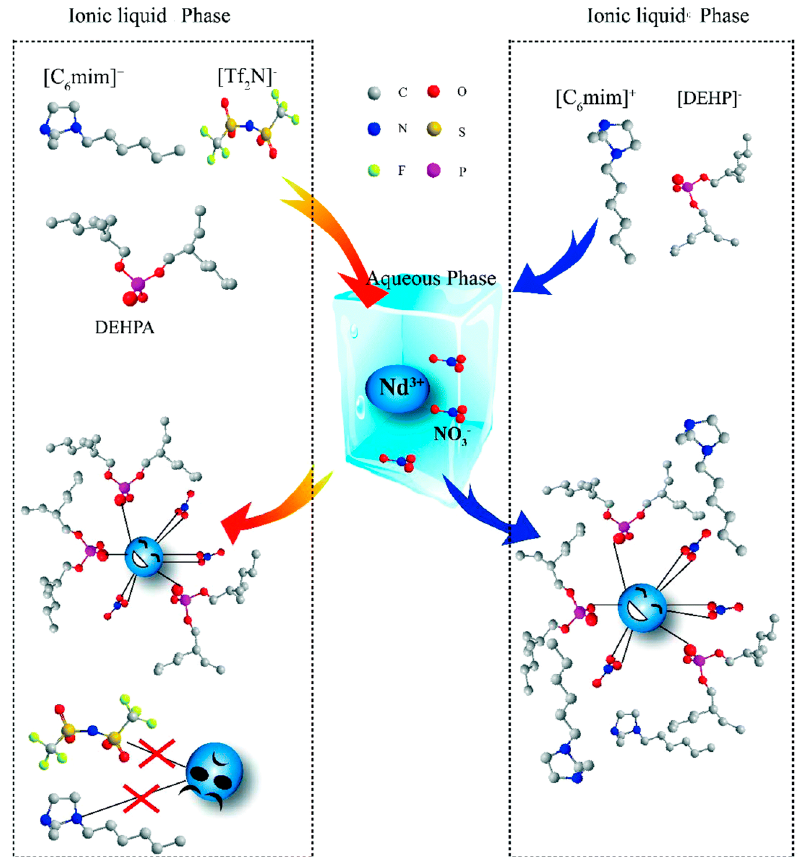
Figure 18. Different Nd 3+ extraction behaviors in [C 6 mpyr][Tf 2 N]/DEHPA and [C 6 mim][DEHP] Figure 18. Di ff erent Nd 3 + extraction behaviors in [C 6 mpyr][Tf 2 N] / DEHPA and [C 6 mim][DEHP] systems [143]; published by Royal Society of Chemistry, 2017. systems [143]; published by Royal Society of Chemistry,